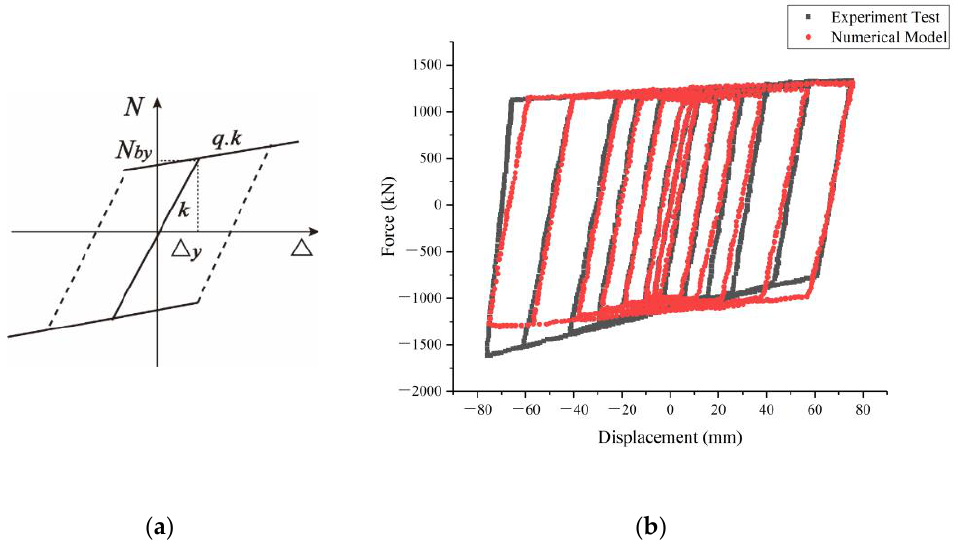
Figure 10. ( a ) Bilinear restoring force model of BRB and ( b ) comparison of experimental and numer- ical models.